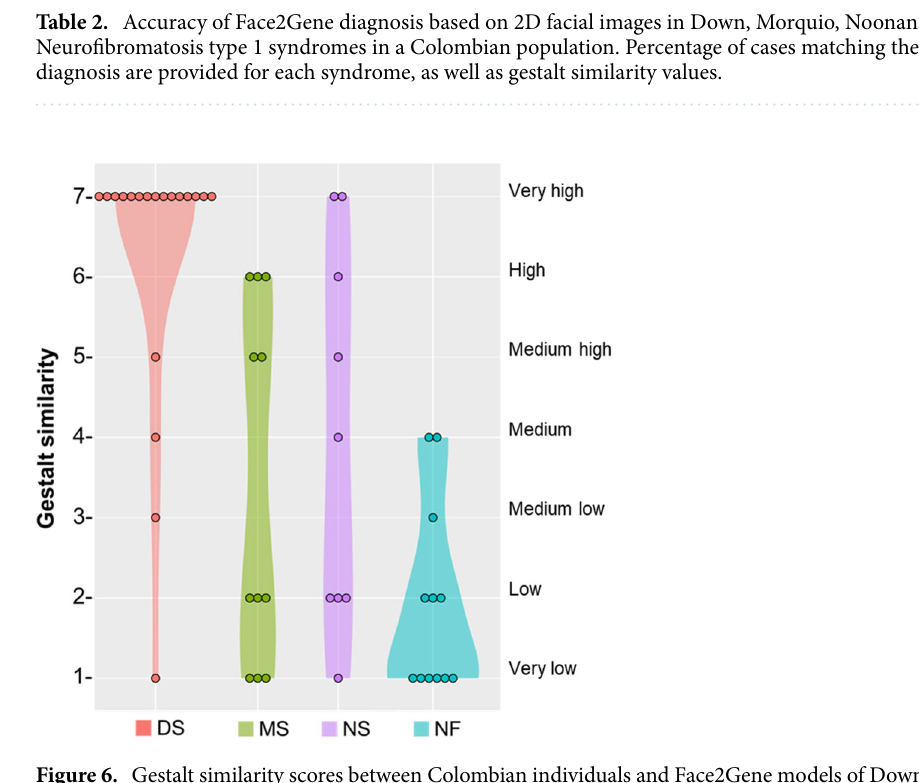
Figure 6. Gestalt similarity scores between Colombian individuals and Face2Gene models of Down, Morquio, Noonan and Neurofibromatosis type 1 syndromes. Violin plots are based on top-5 accuracy Face2Gene predictions within family disorder. Each plot shows the number of individuals scored at each gestalt similarity level, from very high to very